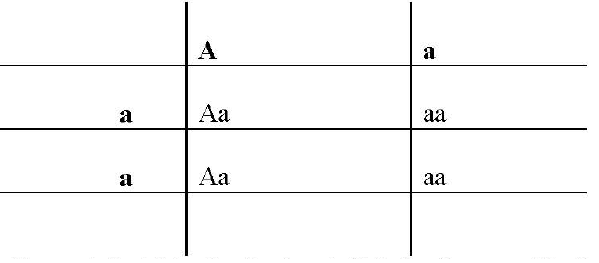
Figure 1. Let A be the dominant allele for the gene. If only one parent has a single copy of a dominant allele for the dominant disease, their children will have a 50% chance of inheriting the disease and 50% of being